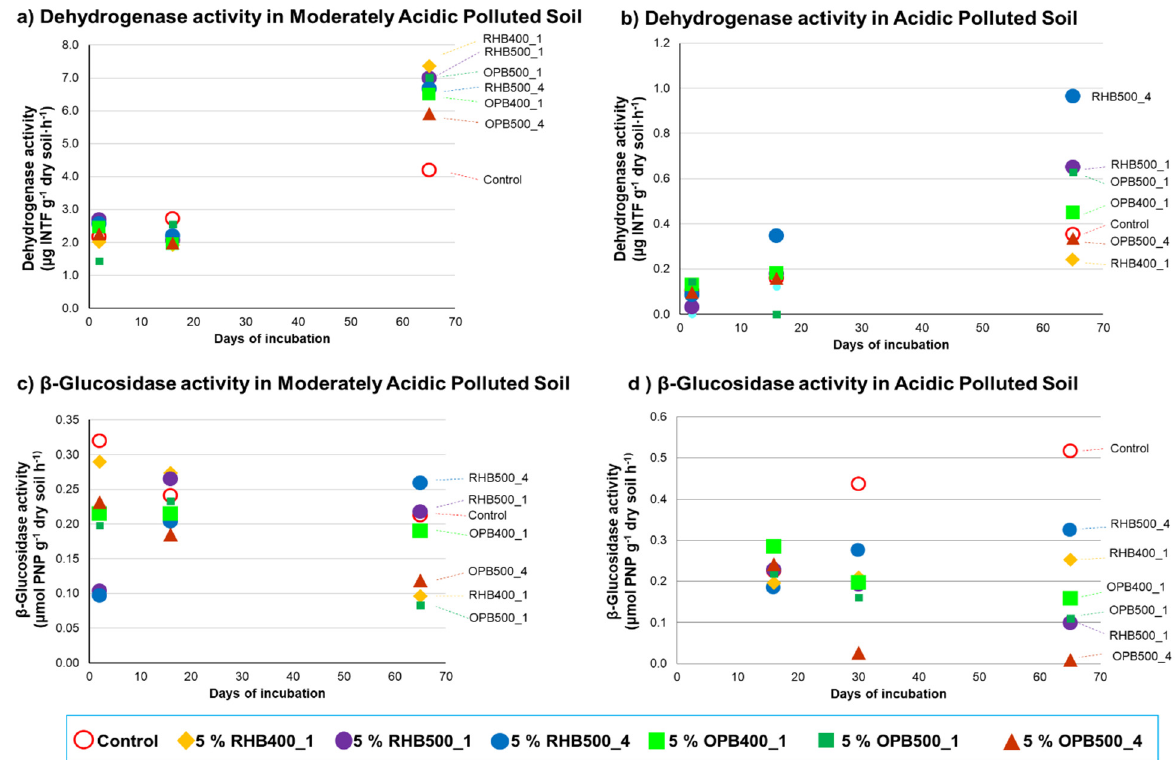
Figure 3. Enzymatic activity in control and 5%-biochar-amended soils during incubation: ( a ) dehydrogenase activity in MAPS, ( b ) dehydrogenase activity in APS, ( c ) β -glucosidase activity in MAPS and ( d ) β -glucosidase activity in APS.